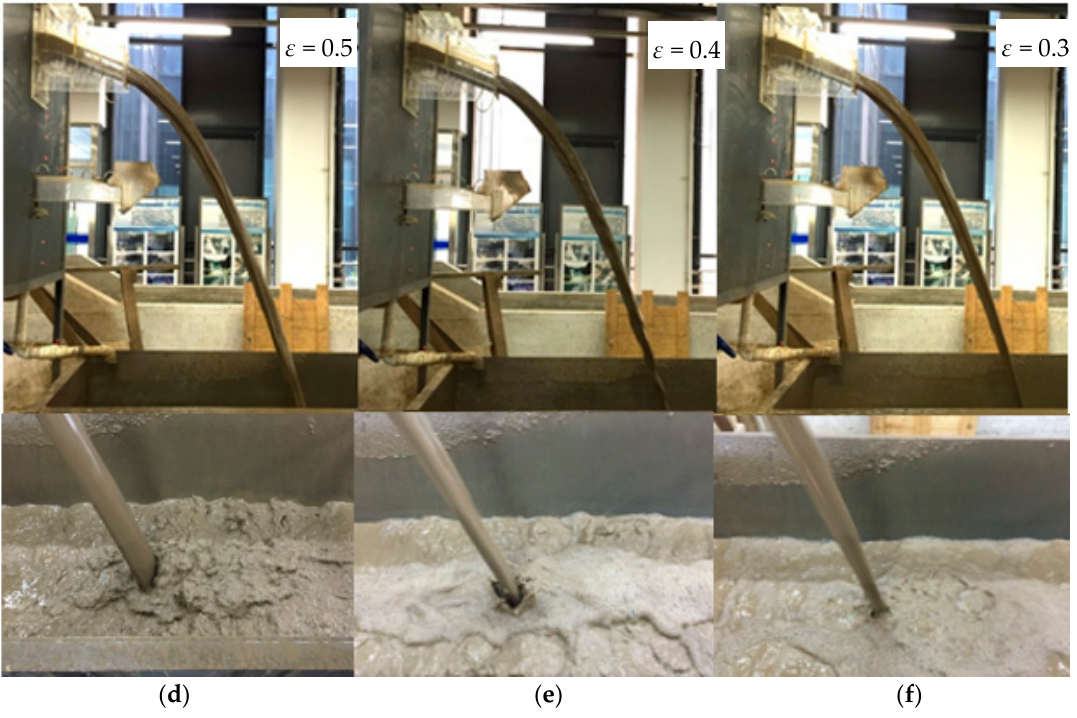
Figure 5. Water nappe regime at upstream water head of 2.20 m and downstream water head of 0.15 m: ( a ) fresh water at ε of 0.5; ( b ) fresh water at ε of 0.4; ( c ) fresh water at ε of 0.3; ( d ) sediment-laden flow with a concentration of 250 kg/m 3 at ε of 0.5; ( e ) sediment-laden flow with a concentration of 250 kg/m 3 at ε of 0.4; ( f ) sediment-laden flow with a concentration of 250 kg/m 3 at ε of 0.3.